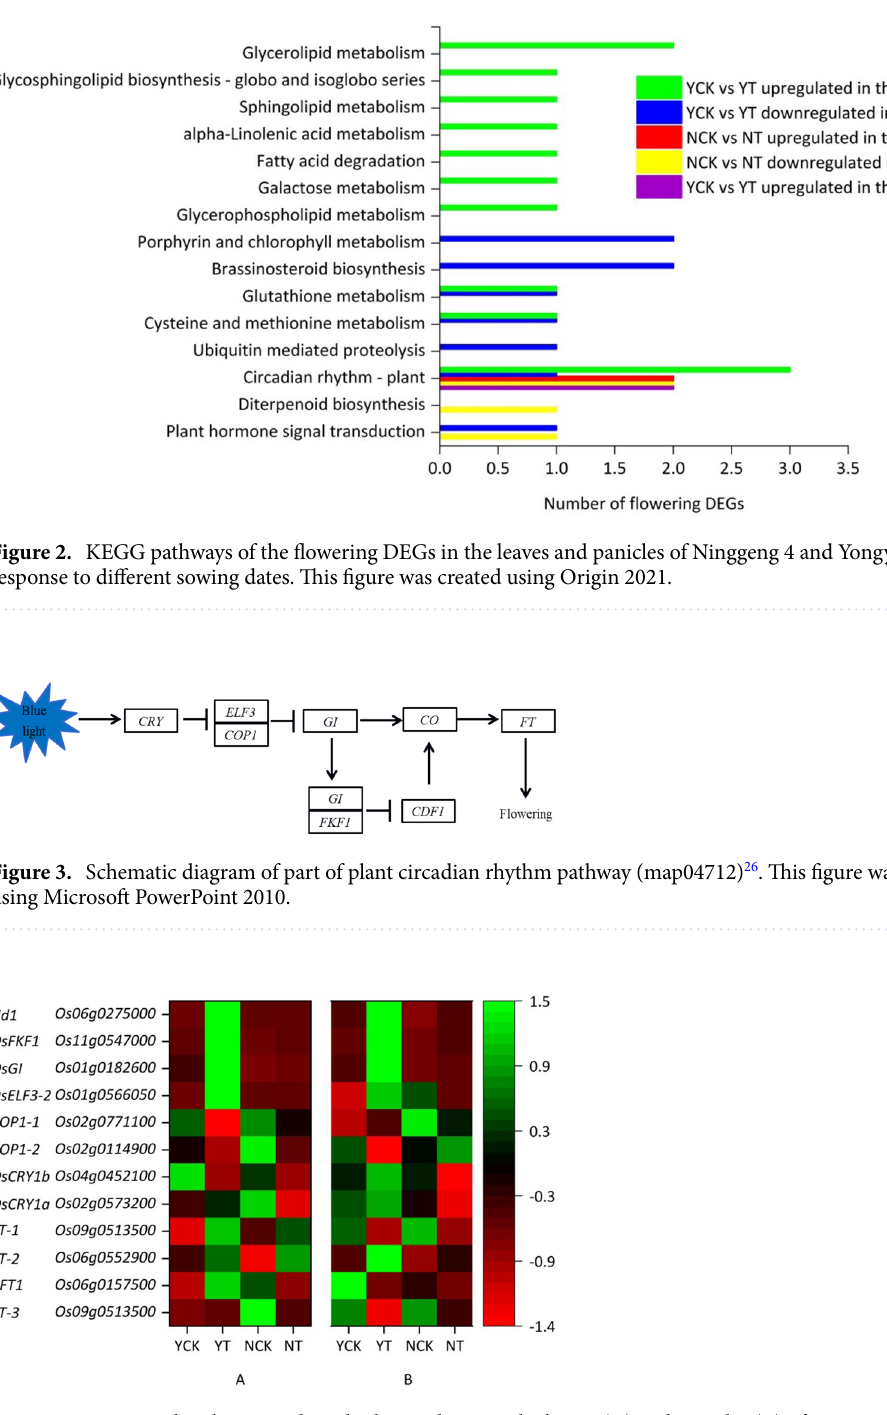
Figure 4. DEGs in the plant circadian rhythm pathway in the leaves ( A ) and panicles ( B ) of Ninggeng 4 and Yongyou 538 sown on two sowing dates. This figure was created using Origin